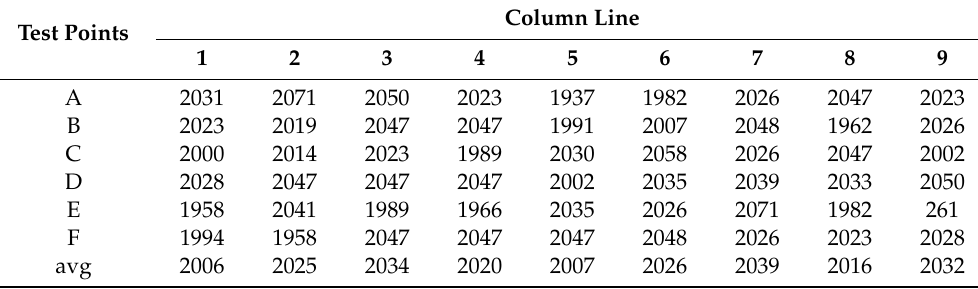
Table 4. S-wave velocities (m / s) at test grid points in the S24D210 slab (unit: m / s).